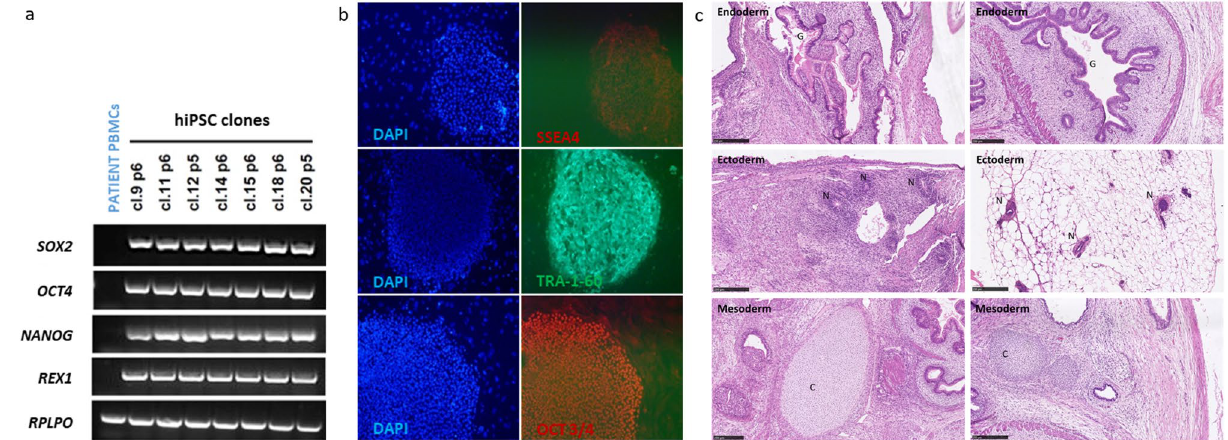
Figure 2. Generation and characterization of hiPSCs. ( a and b ) Endogenous expression of pluripotency-related markers by patient 2-derived iPSCs: ( a ) RT-PCR analysis for detection of the pluripotency markers SOX2 , OCT4 , NANOG and REX-1 . Full length gels are showed in Supplementary Fig. S5; ( b ) Immunofluorescence staining of three stem cell proteins (SSEA4, TRA-1–60 and OCT3/4) in patient iPS clones 15 and 20. ( c ) Germ cell layer components within teratomas obtained with patient 2-derived iPSCs. The differentiation, at passage 8 (cl.15) and 7 (cl.20), of iPSCs into ectoderm, endoderm and mesoderm was evaluated on whole sections stained with hematoxylin and eosin, for iPS clones 15 (left panel) and 20 (right panel). Hematoxylin and eosin stain, X20. Images of immunofluorescence staining were analyzed using MetaMorph (Molecular Devices, https:// fr. molec ulard evices. com) and ImageJ 1.52 (National Institutes of Health, https:// imagej. nih. gov) Softwares. C cartilage, EB embryoid body, G gut epithelial tissue, hiPSC human induced pluripotent stem cells, N neural